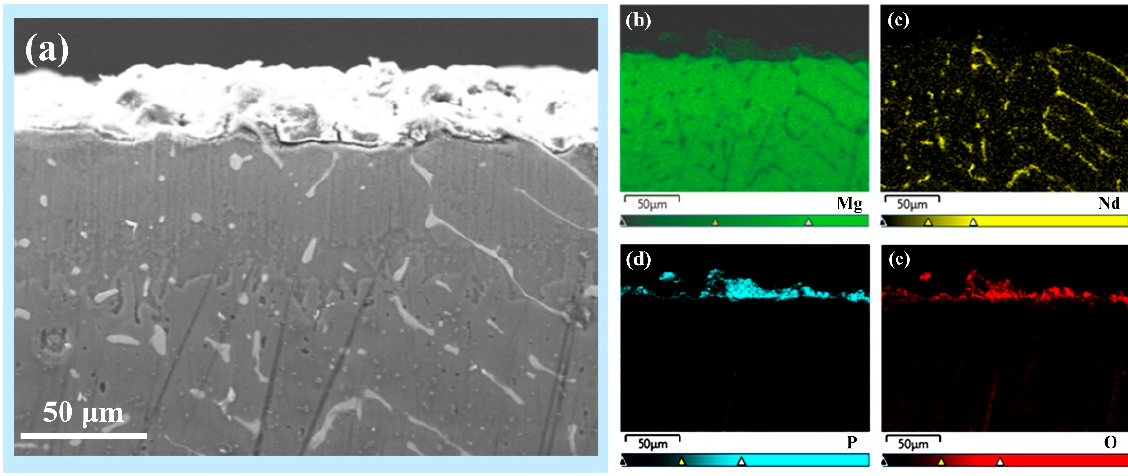
Figure 4. EDS mapping of the cross-section of the coated sample after PFDS-modification: ( a ) SEM image of the selected region, ( b – e ) maps showing the distribution of the elements.